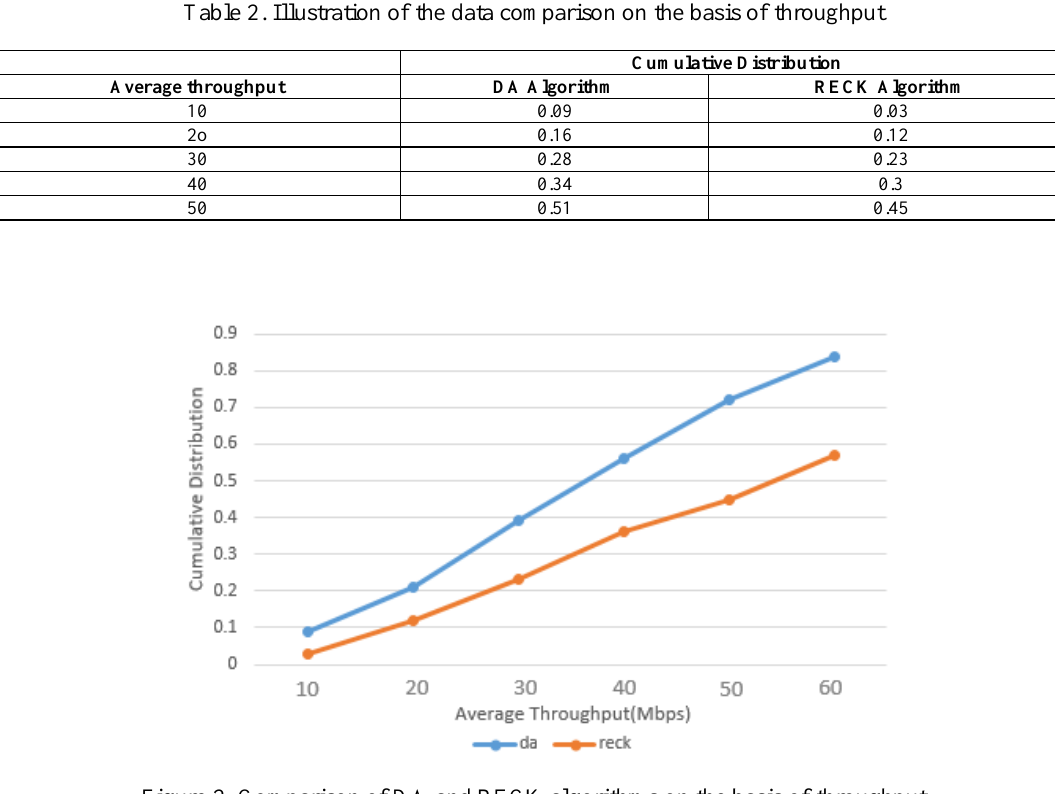
Figure 2. Comparison of DA and RECK algorithms on the basis of